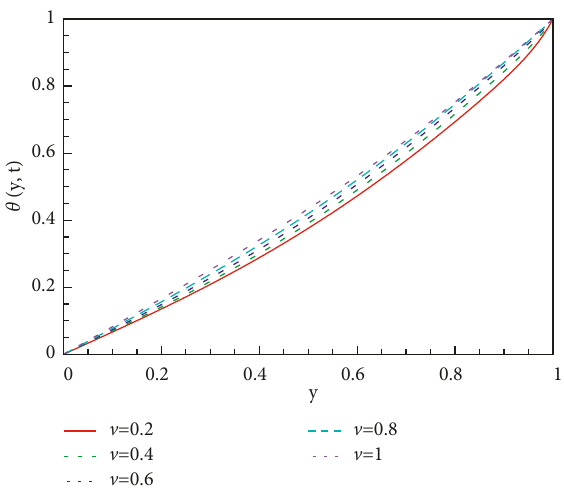
Figure 12: Influence of α � β � ] on θ when λ α